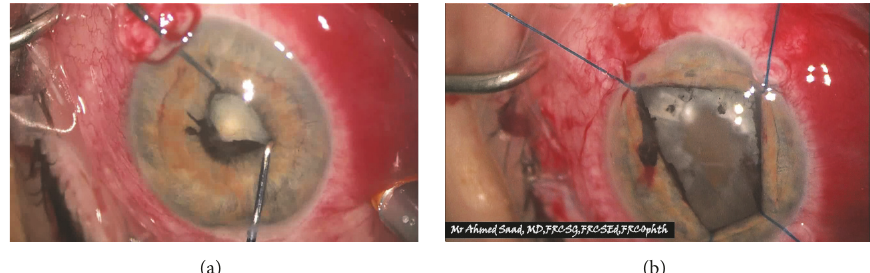
Figure 4: Synechiolysis and iris stretching prior to phacoemulsification with iris hooks & vitrectomy of the second eye.